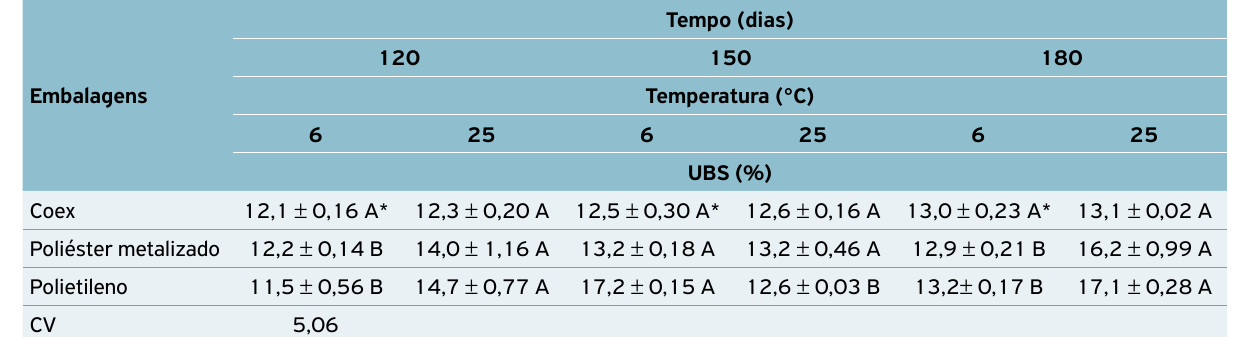
Tabela 5. Média e erro padrão do conteúdo de água (umidade em base seca) de uma mistura granulada com conídios de B.bassiana acondicionada em 3 tipos de embalagens armazenadas em refrigerador (6 ± 2°C) e em câmara climatizada (25 ± 1°C) durante